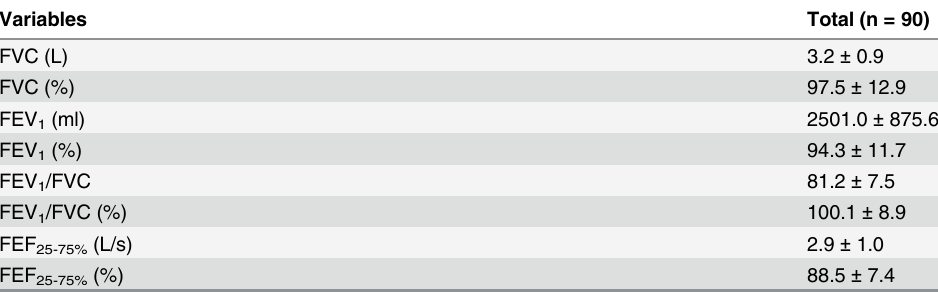
Results are expressed as mean ± SD. FVC, forced vital capacity; FVC, percentage of predicted FVC; FEV 1 , forced expiratory volume in one second; FEV 1 , percentage of predicted VEF 1 ; FEV 1 /FVC, forced expiratory volume in one second/ forced vital capacity; FEV 1 /FVC, percentage of predicted forced expiratory volume in one second/forced vital forced expiratory fl ow between 25 and 75% FVC.